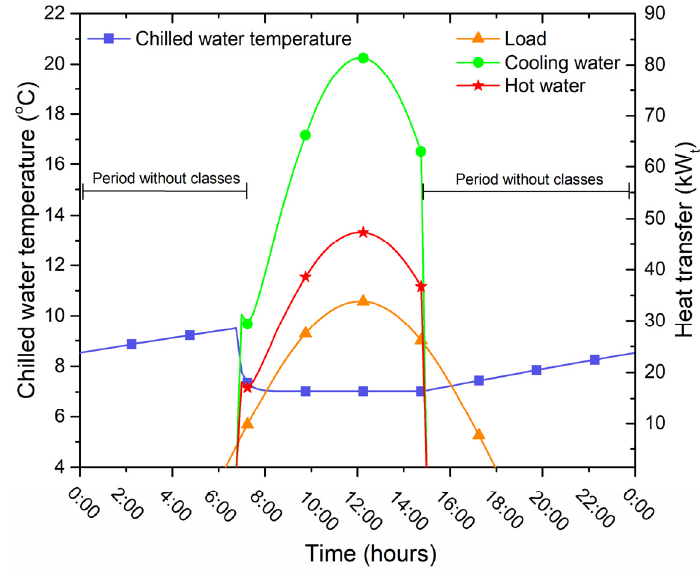
Figure 5. Chilled water temperature and heat transfer of the circuits.